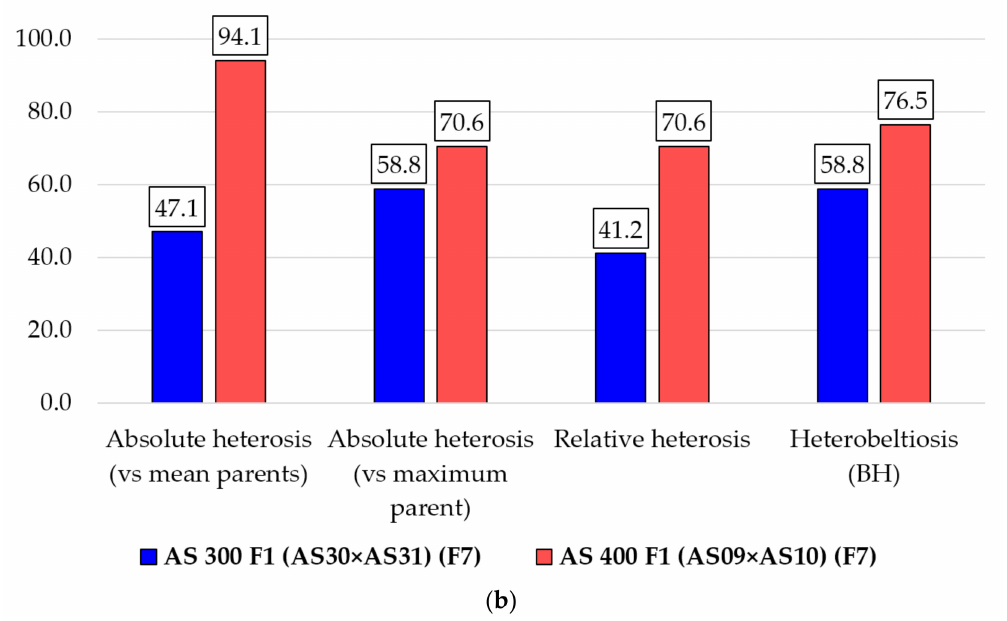
Figure 5. Types of heterosis of the traits represented by the chemical content of tomatoes according to genetic material (parental lines of the two newly created commercial hybrids, AS 300 F1 and AS 400 F1) and the direction of heterosis: ( a ) Positive; ( b )